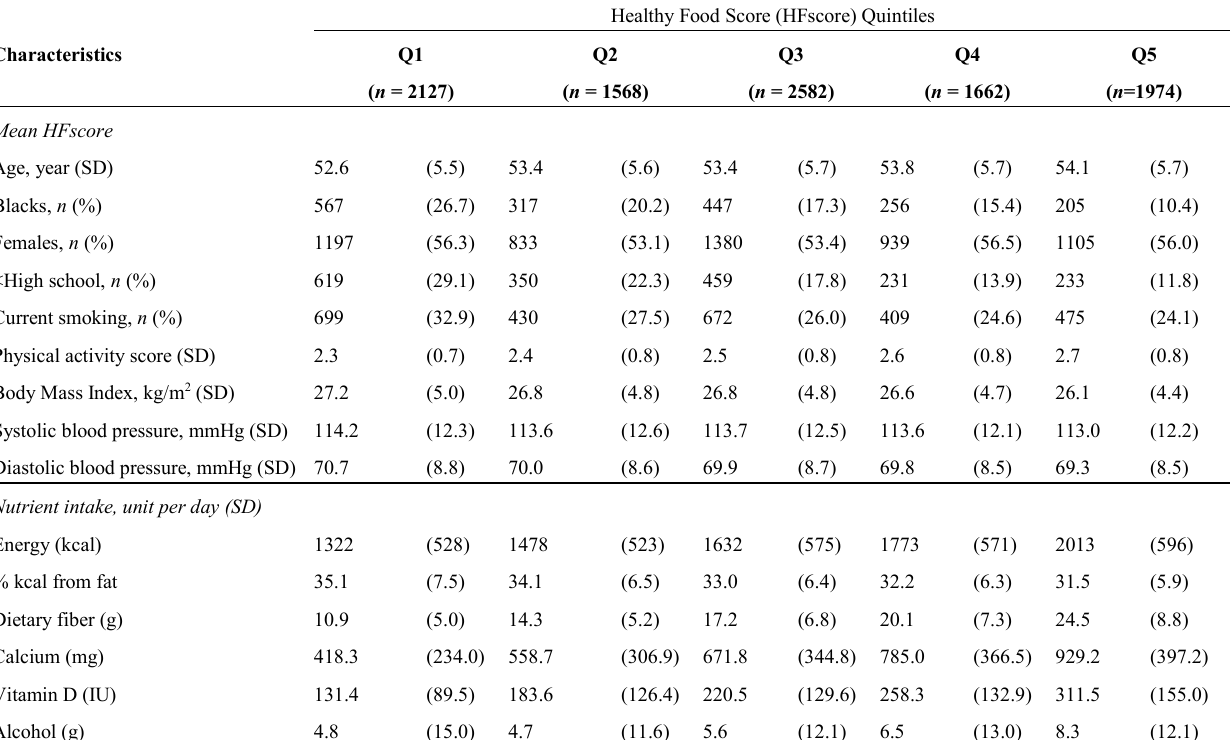
Table 2. Unadjusted mean (SD) and frequency (%) characteristics at baseline across Healthy Food Score quintiles among African American and white adults who were not hypertensive at baseline, ARIC ( n = 9913),